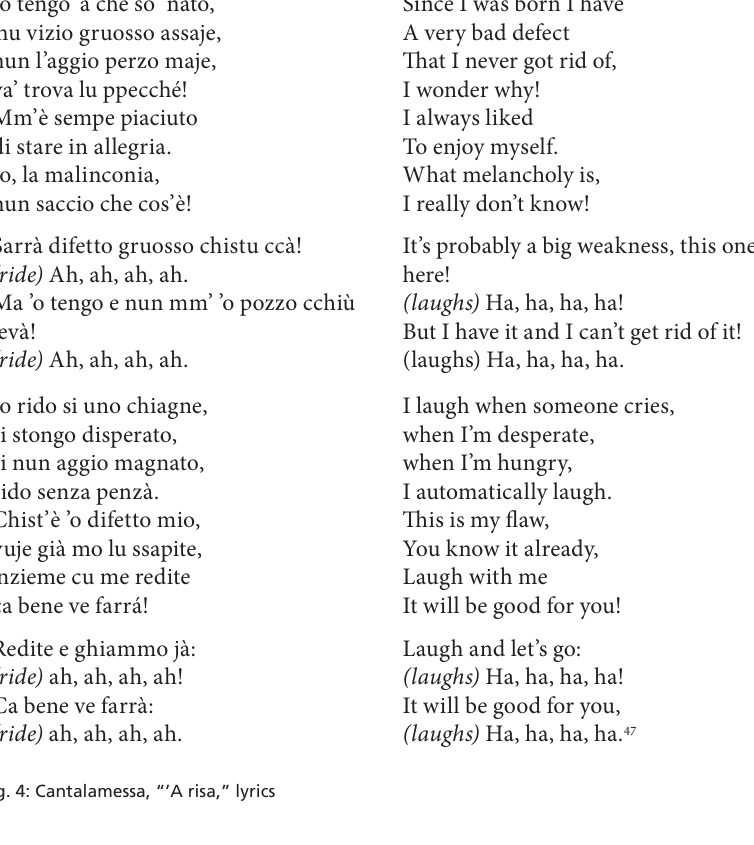
Fig. 4: Cantalamessa, “’A risa,” lyrics